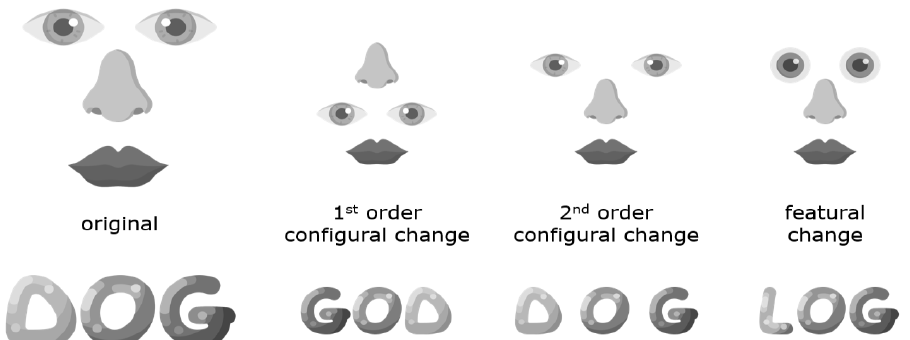
Figure 3. Maurer et al. [119] distinguish between three types of configural processing: sensitivity to first-order relations (relative position of features), holistic processing (gluing features into a gestalt or whole), and sensitivity to second-order relations (absolute distances between features). Featural processing has been used to describe processing individual object components or parts. Different manipulations of visual stimuli have been used to encourage the use of these types of visual processes (for a critical discussion on visual processes and how to measure them, see e.g., [120,121]. Recognition by parts as well as whole word shape have been suggested to independently contribute to reading, although the former likely plays a greater role than the latter [122]. Icons by Flaticon.com, (accessed on 20 September 2021).